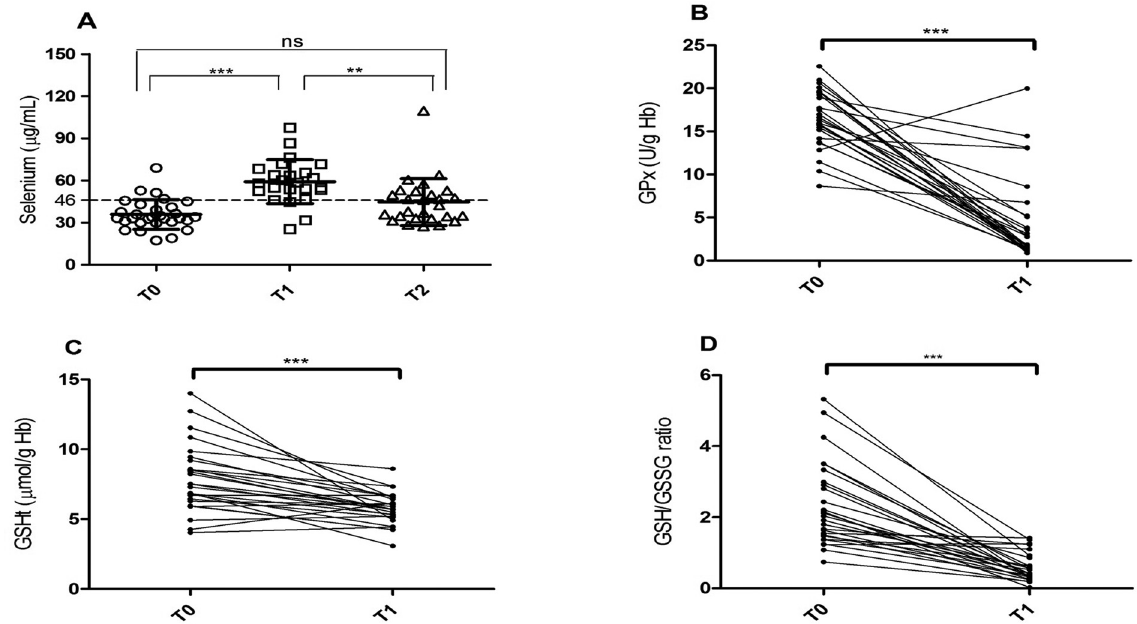
Figure 1 - Selenium, GPx and GSHt activity. (A) Selenium levels in MPS patients at baseline (T0), 6 months (T1) and 12 months (T2) after supplementation. The dotted line means the cutoff value for normal Selenium level. Tukey’s Multiple Comparison Test: ** p <0.01, *** p <0.001. (B) GPx activity at baseline (T0) and 6 months after (T1) selenium supplementation. (C) GSHt activity at baseline (T0) and 6 months after (T1) selenium supplementation. (D) GSH/GSSG ratio at baseline (T0) and 6 months after (T1) selenium supplementation. Paired t -test: ** p <0.01, *** p <0.0001.